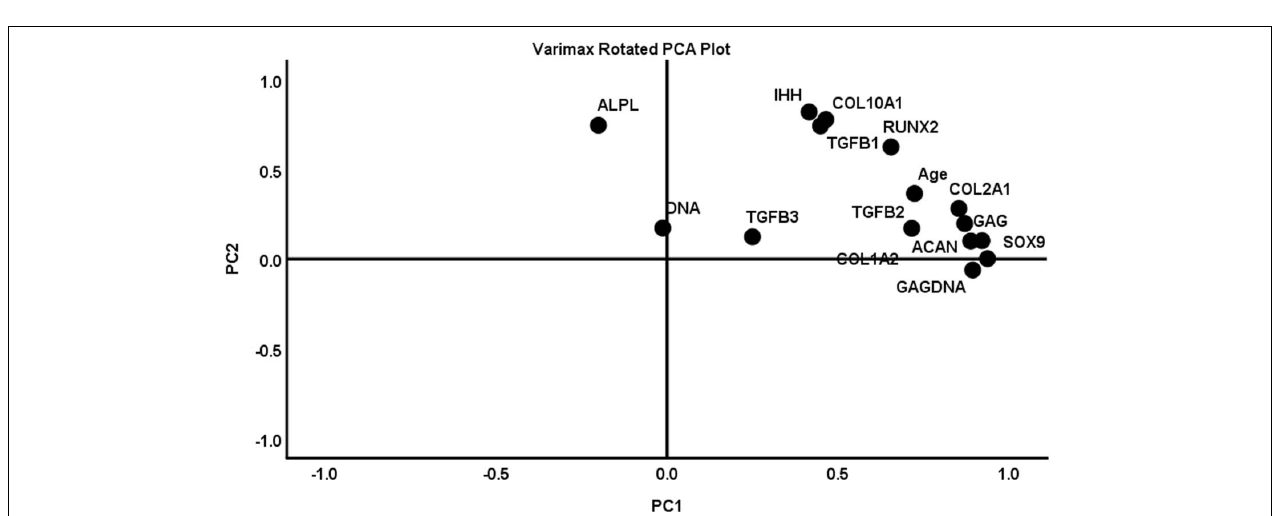
FIGURE 9 | A varimax rotated plot of a two-component solution of principal component analysis of measured variables. Measured variables are as follows: ACAN , age, ALPL , COL1A2 , COL2A1 , COL10A1 , DNA, GAG, GAG/DNA (GAGDNA), IHH , RUNX2 , SOX9 , TGF β 1 , TGF β 2 , and TGF β 3 . Principal component 1 (PC1) is on the x -axis and principal component 2 (PC2) is on the y -axis. The position of each variable on the plot indicates the degree to which it loads on the two different principal components.